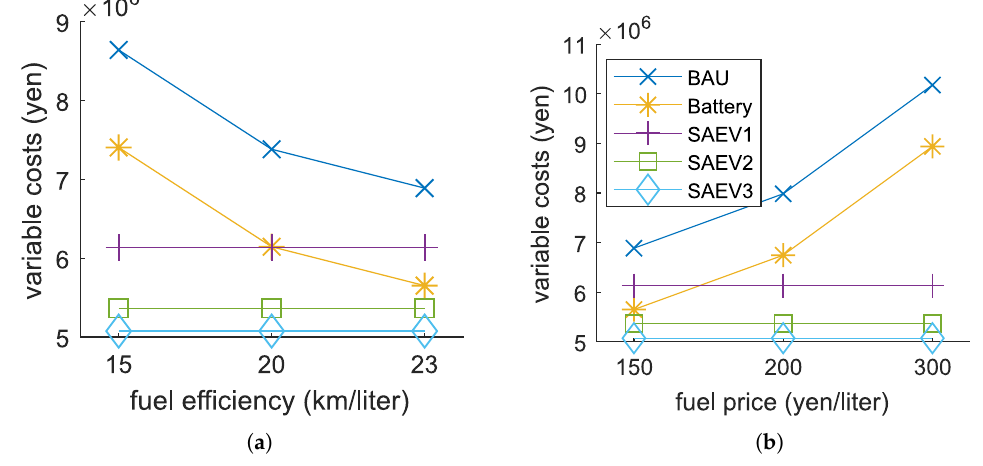
Figure 6. Sensitivity of variable costs to: ( a ) HEV fuel efficiency; and ( b ) Fuel cost.